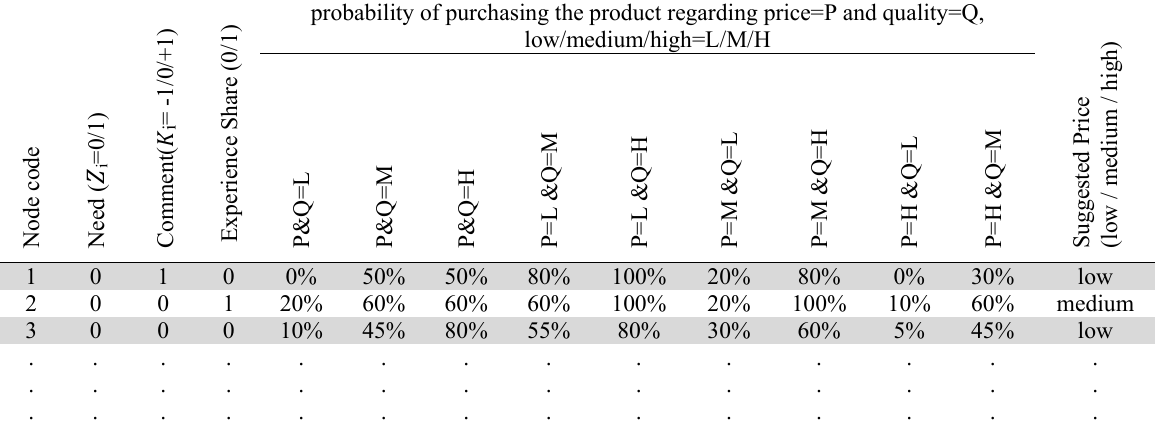
Table 3 Sample of node data